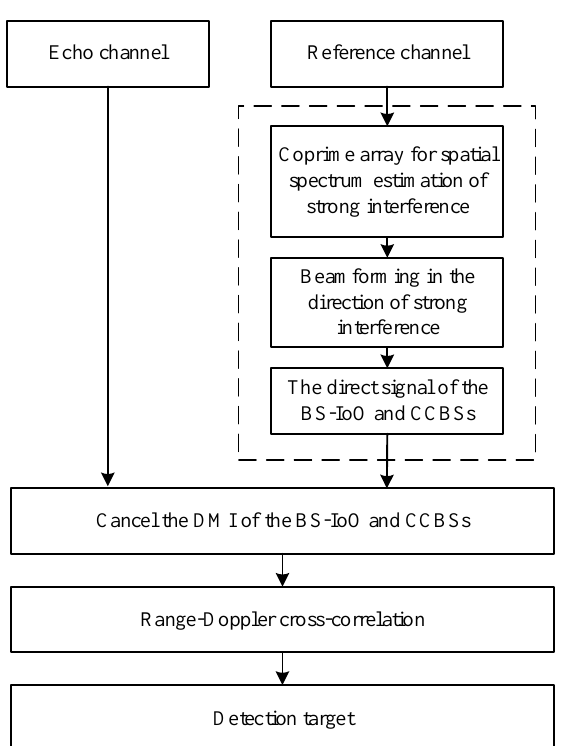
Figure 3. Signal processing process of passive radar for mobile communication.